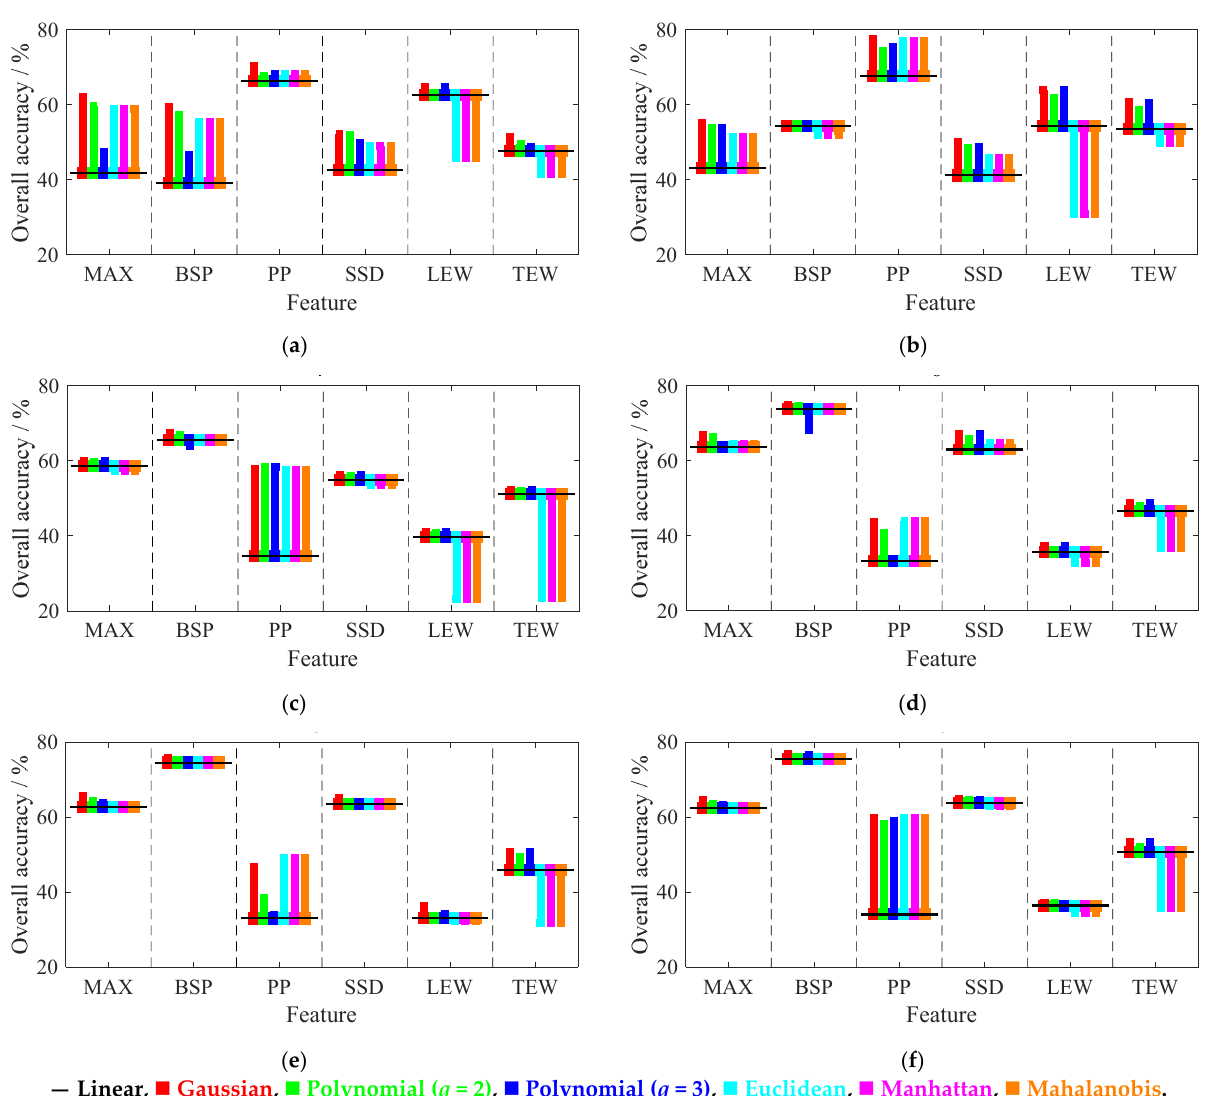
Figure 10. Overall accuracies of single features of KNN and SVM settings: ( a ) 0°; ( b ) 2°; ( c ) 4°; ( d ) 6°; ( e ) 8°; ( f ) 10°.